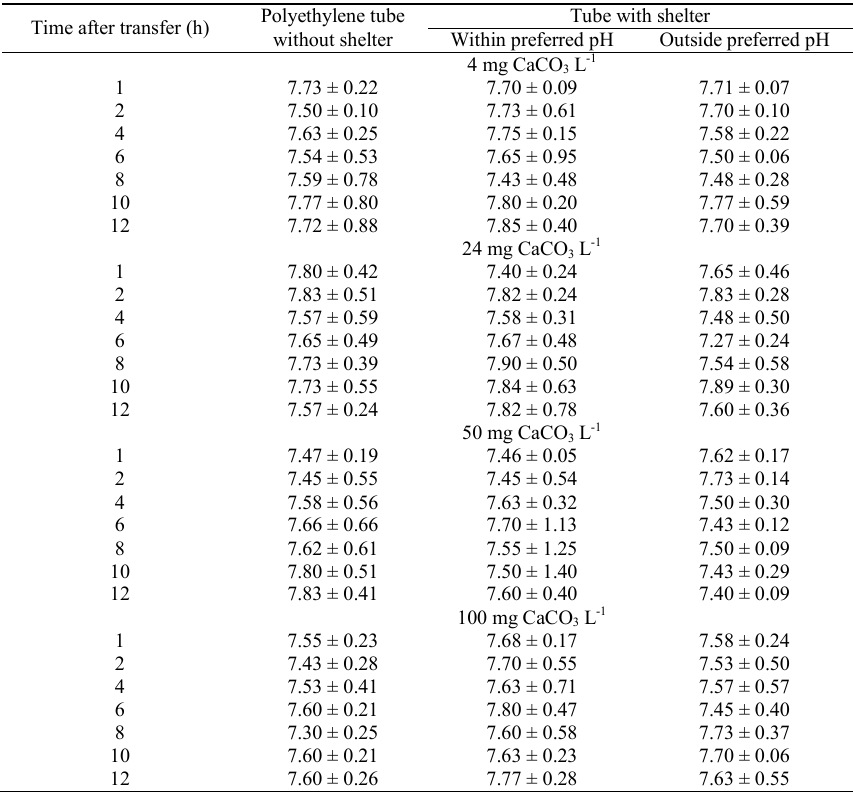
Table 1. Preferred pH of silver catfish acclimated to different water hardness. Values are reported as mean ± SEM. Water hardness or the presence of shelter in the tube did not significantly change the preferred